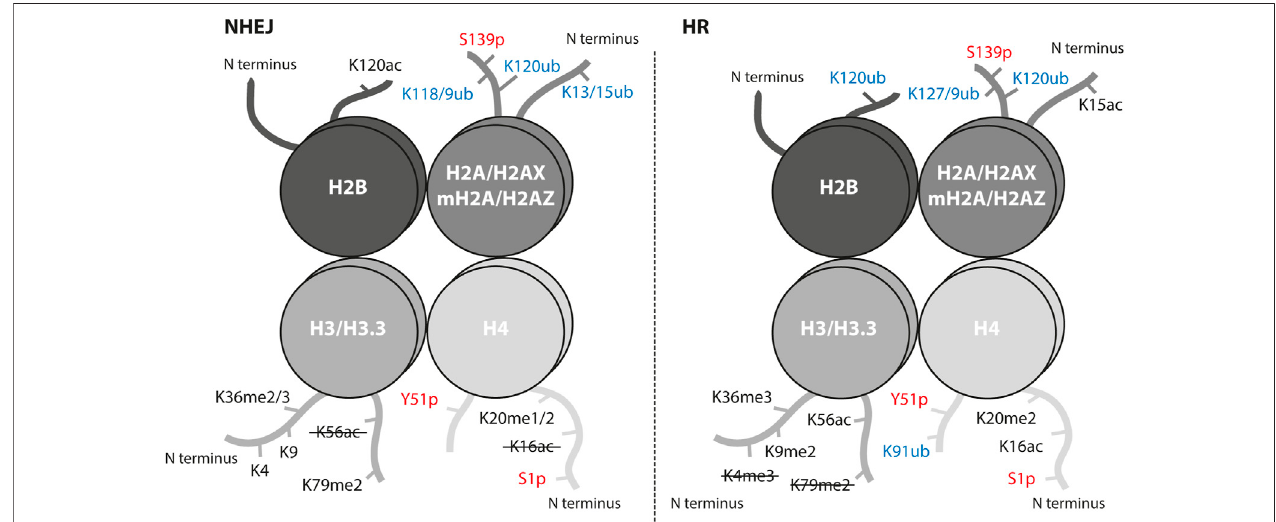
FIGURE 1 | Histone post-translational modi fi cations associated with NHEJ and HR repair pathways. Interaction of proteins and successful crosstalk between damagesignalingandrepairmechanismatthesitesofDSBsisachievedbyahighlycontrollednetworkofPTMs.Histone PTMsplayaroleinDSBrepair pathwaychoice and serve as binding sites for repair proteins. Ubiquitination marks in blue, phosphorylation marks in red; ub, ubiquitination; p, phosphorylation; ac, acetylation; me, methylation. The crossed-out mark means it is removed in the repair pathway.